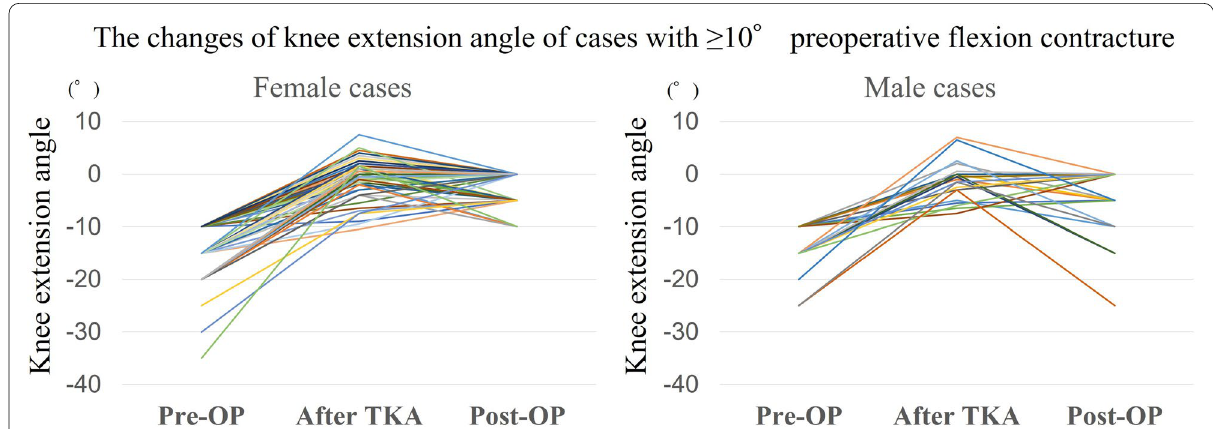
10° preoperative flexion contracture. Pre-OP, preoperative knee ≥